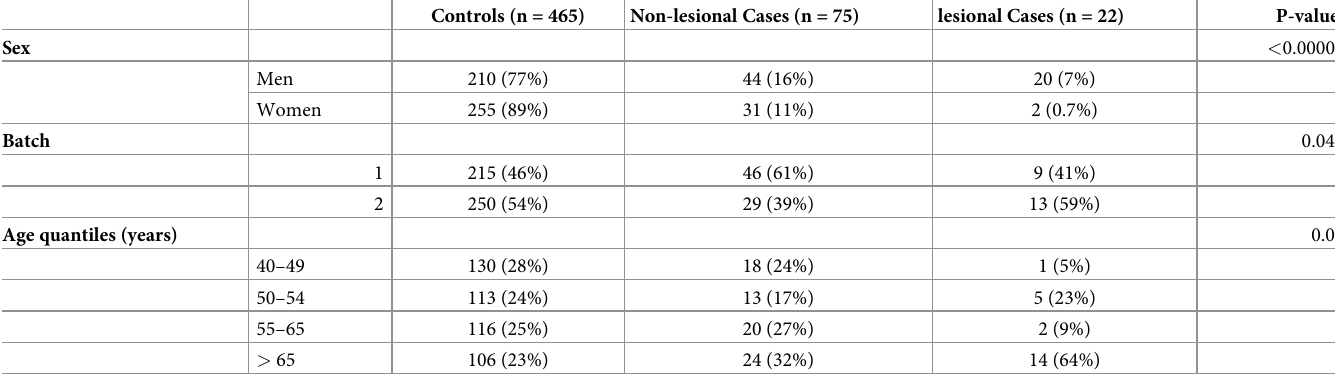
Table 1. Descriptive statistics of participants with skin